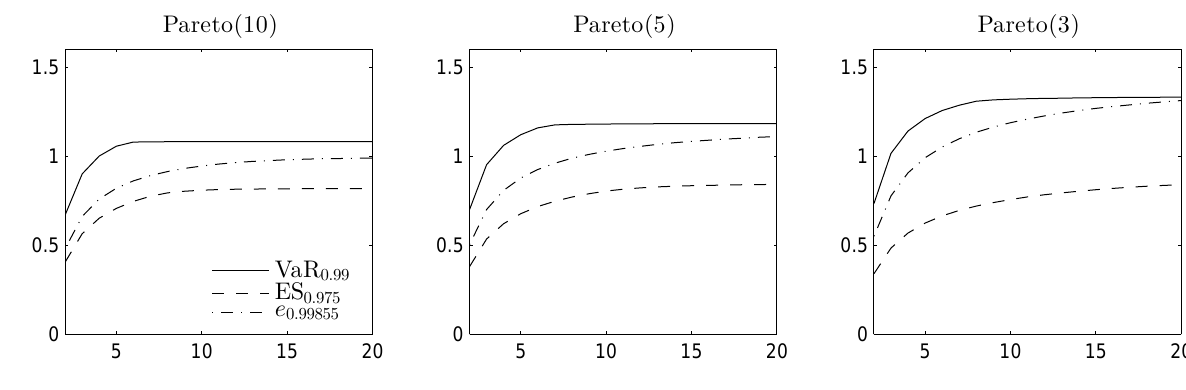
Figure 4. DU spread for VaR, expected shortfall (ES) and the expectile of the sum of d Pareto p θ q distributed margins, with d on the horizontal axis. The DU spread is given relative to ES `